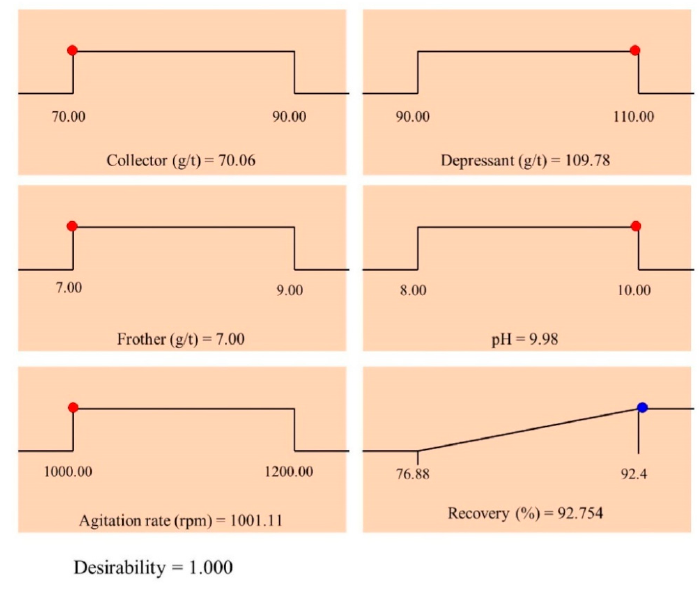
Figure 6. The optimum values of factors to achieve the maximum Cu recovery.